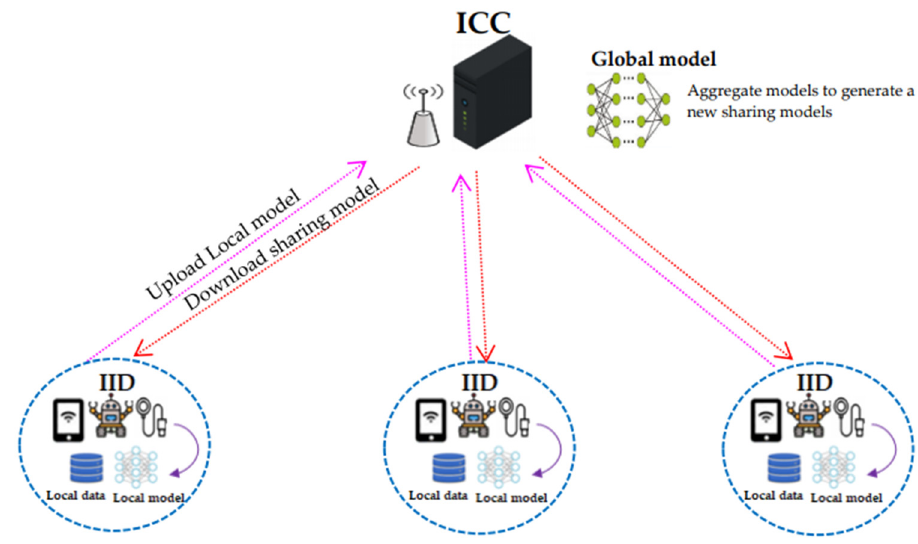
Figure 1. System